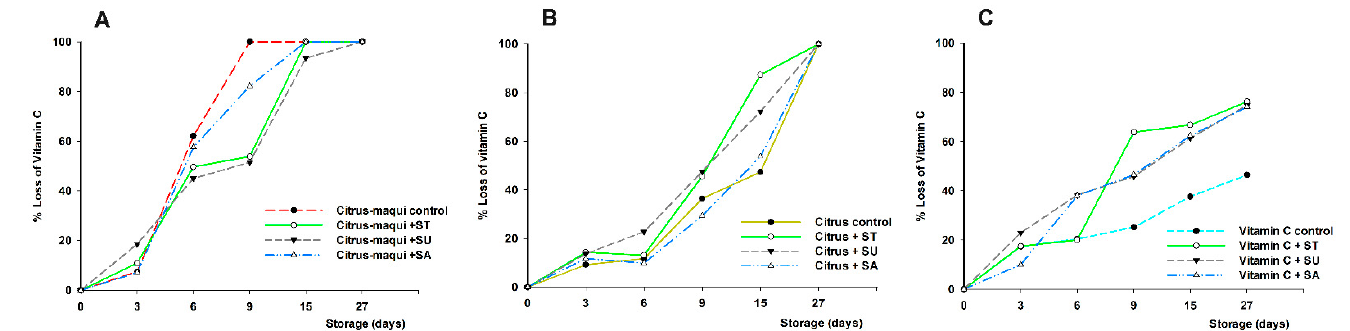
Figure 5. Percentage of loss of vitamin C in citrus–maqui beverage ( A ), citrus juice ( B ), and vitamin C solution ( C ), with added sweeteners stevia (ST), sucralose (SU), and sucrose (SA) or without (control), measured during storage for 27 days at 4 °C. Significantly different concentrations’ absolute values at days 9, 15, and 27, for ( A – C ), respectively, according to statistical analysis (ANOVA and Tukey’s multiple rank test) were found at p < 0.001.